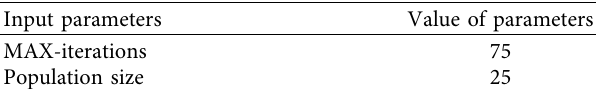
Table 23: Initial parameters of fruit fly.